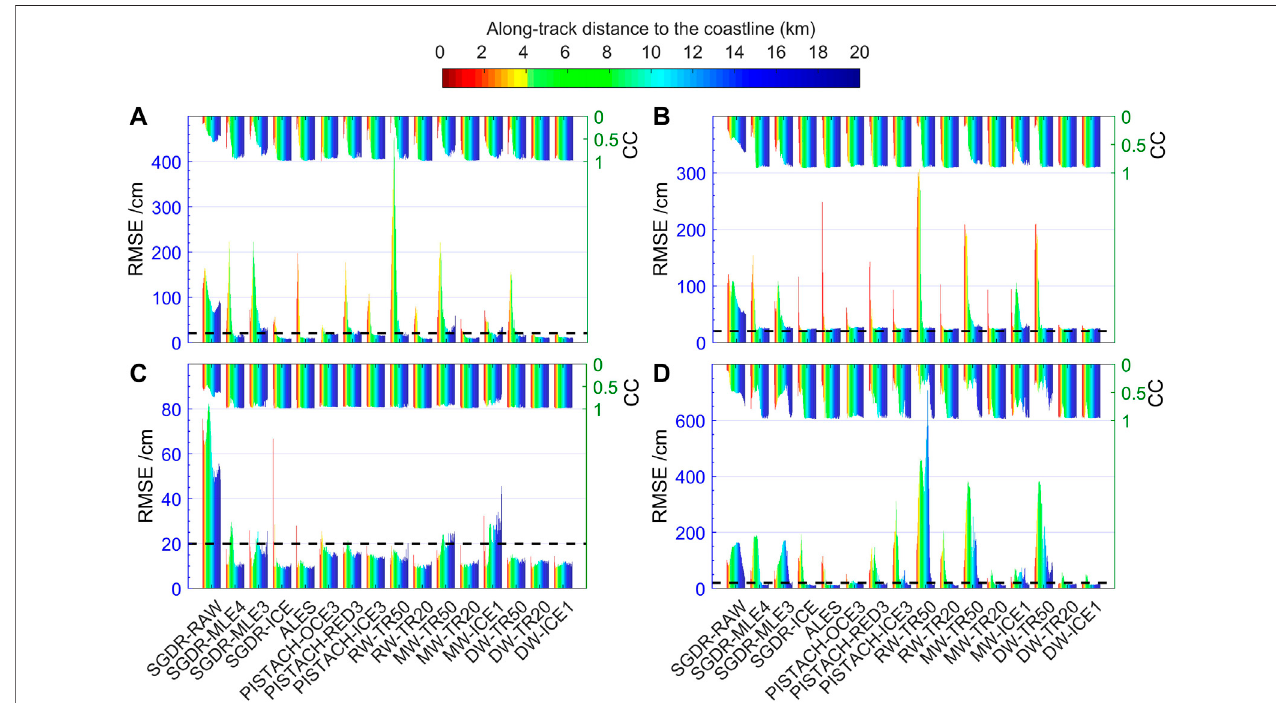
FIGURE 5 | RMSE and correlation coef fi cients (CCs) of retracked SSH time series within 20 km offshore w.r.t. tide gauge data in each test area. (A) Los Angeles; (B) Cape May; (C) Funchal; (D) Ko Lak. The color of the bar changes from red to blue, indicating along-track distance to the coastline rising from 0 to 20 km. The black dashed line denotes the accuracy level of 20